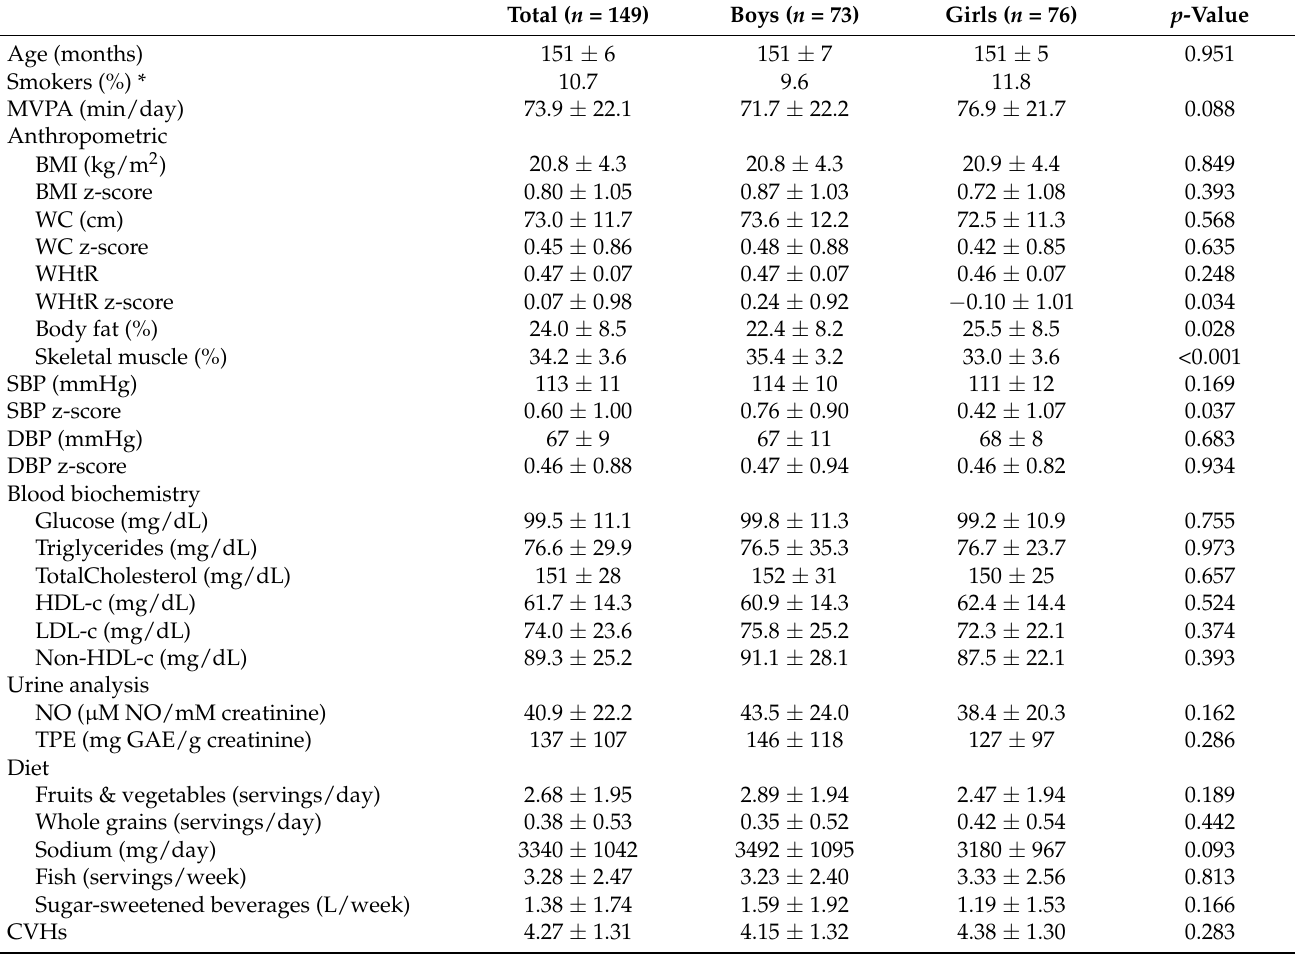
Table 1. General characteristics of the participants analyzed by